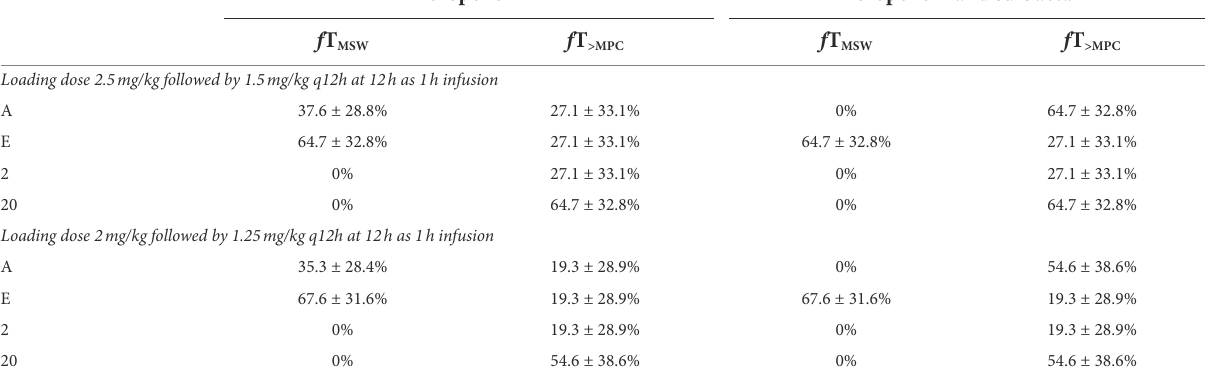
TABLE 8 Pharmacodynamic parameters f T MSW and f T >MPC based on MIC and MPC of polymyxin-B in the epithelial lining fluid against four A. baumannii isolates harboring OXA-23 and other serine- β -lactamases. Bacteria Isolate Polymyxin-B in double-combination with Polymyxin-B in triple-combination with meropenem ‡ meropenem and sulbactam